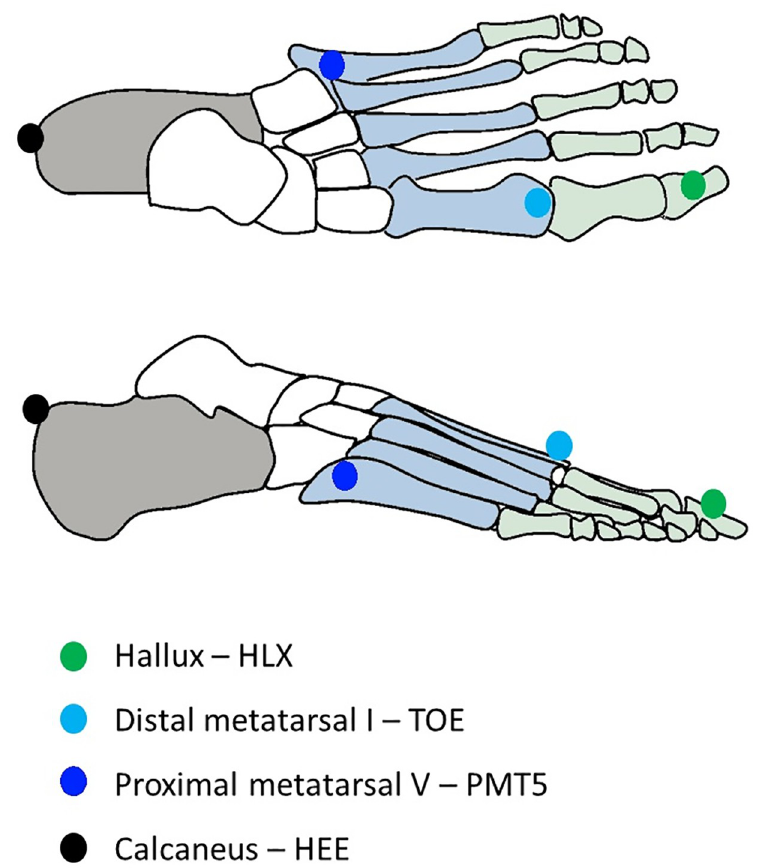
Fig 2. An overview of foot markers used within analysis. The grey area indicates the part of the foot used by the HS group for IC, the blue area the part of the foot used by the MF group for IC, and the green area the part of the foot used by the FF group for IC. HS: heel-strike, IC: initial contact with the ground, MF: midfoot, FF: forefoot.